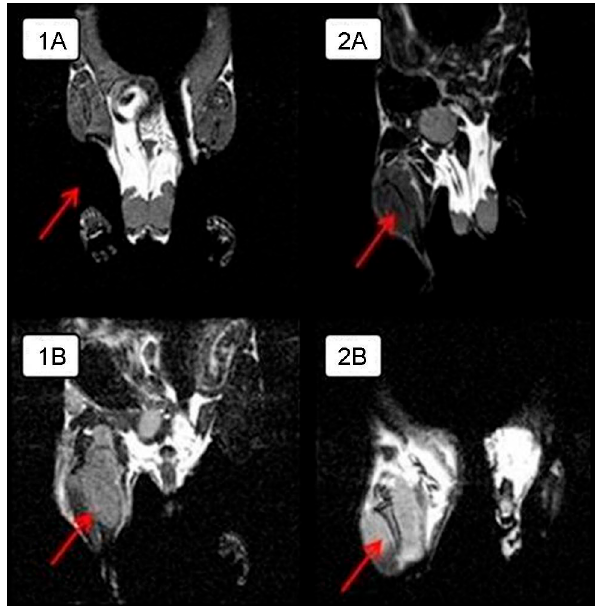
Figure 2. MRI of intramuscular Krebs-2 solid tumor nodes in BALB/c mice in the frontal plane on day 28 from the onset of the experiment. Arrows indicate the tumor. A. Experimental mice receiving intratumoral injections of NDV/Altai/pigeon/770/2011 at a dose of 256 HAU per 100 µL for 5 days: ( 1A )—complete tumor regression compared to the control animals, ( 2A )—significant tumor reduction compared to the control animals; ( 1B , 2B )—control mice treated with saline injections.